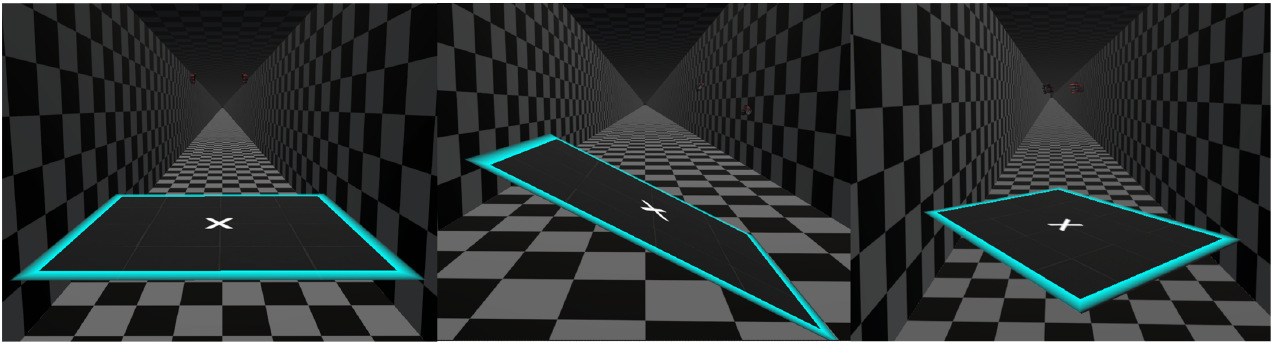
Figure 1. Examples of Linear ( Left ) and Angular ( Centre and Right ) Accelerations during the Ride.